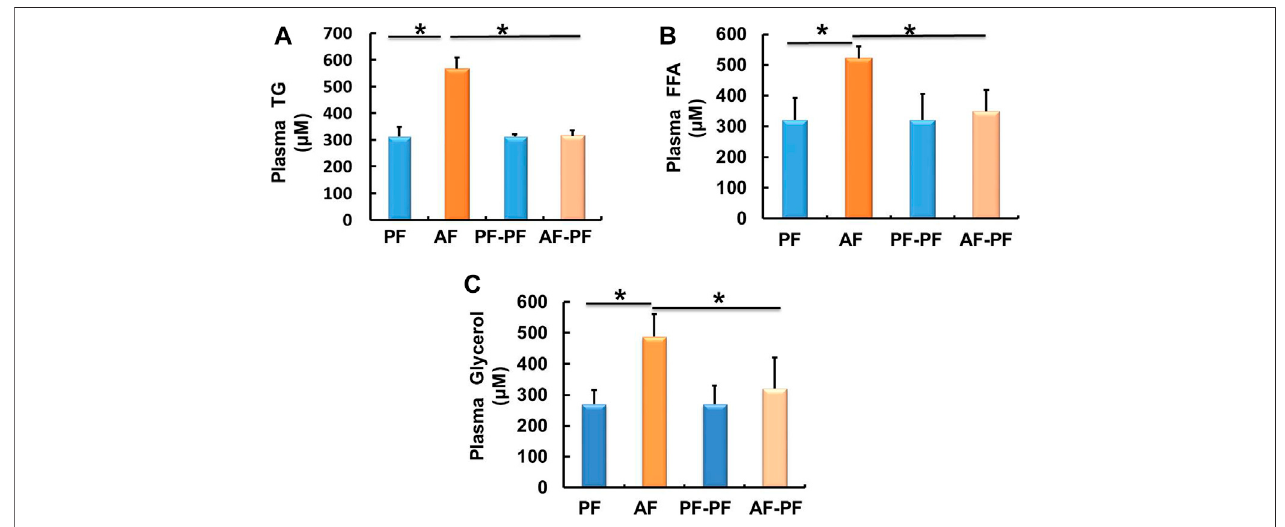
FIGURE 5 | Alcohol withdrawal mitigates alcohol-induced hepatic in fl ammation. (A) The mRNA levels of TNF- α (A) , IL-6 (B) , and IL-1 β (C) in the liver. * p < 0.05 indicates statistically signi fi cant differences (n (cid:1) 6 − 8).